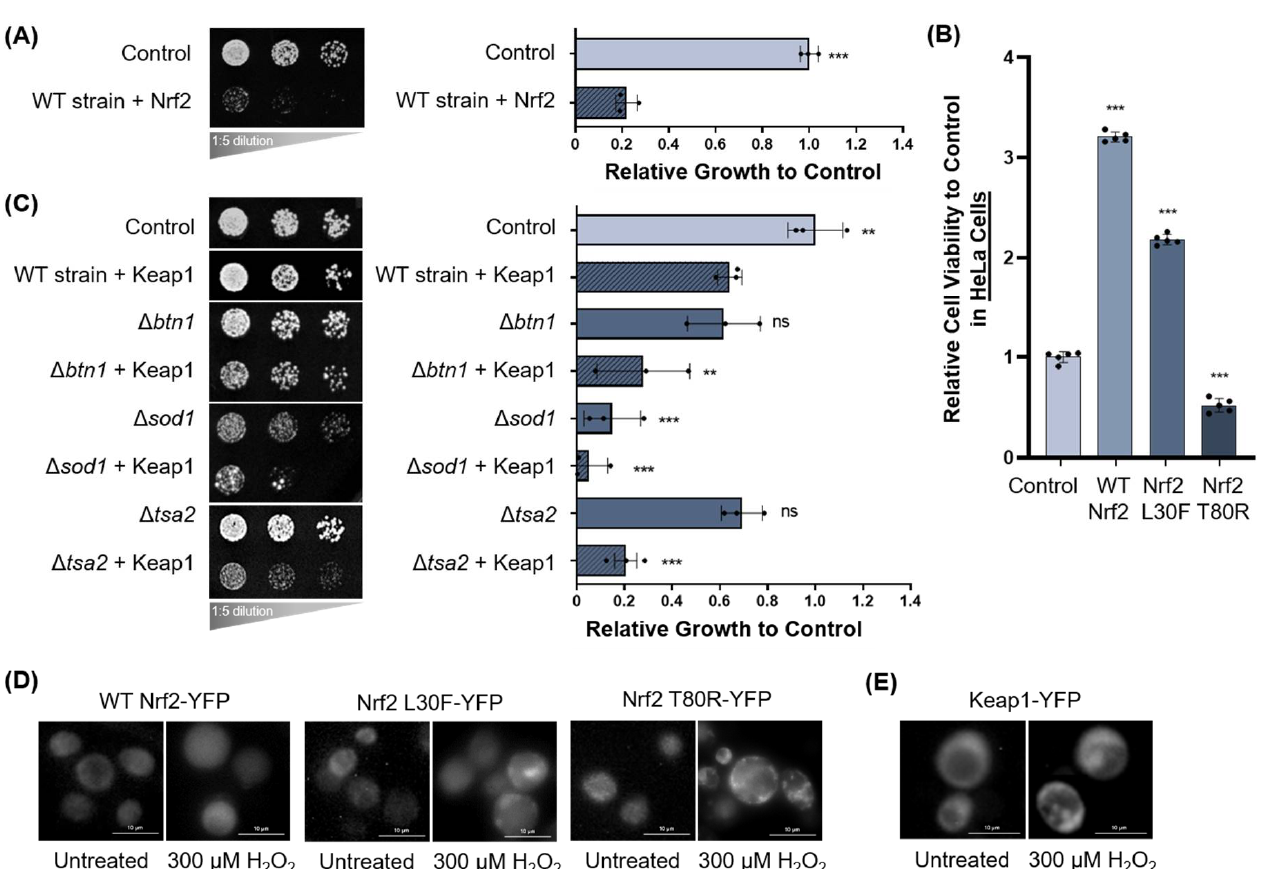
Figure 2. Nrf2 and Keap1 expression is modified by oxidative stress in yeast. ( A ) Growth assays for human Nrf2 transformed into wild-type yeast grown on agar plates. Growth is quantified to the right relative to the empty vector control. Only significant data is shown. ( B ) Relative cell viability of human HeLa cells transfected with wild-type Nrf2 and its mutant variants. ( C ) Human Keap1 transformed into yeast deletion strains for various oxidative stress genes grown on agar plates. Only significant data is shown. Growth is quantified to the right relative to the empty vector control. ( A – C ) Means derived from three biological replicates were used during analysis. Means were analyzed using one-way ANOVA followed by Tukey’s post hoc test. Data are expressed as mean ± SD. p < 0.05 was considered statistically significant; ** p < 0.01, *** p < 0.001; p = ns (non-significant). ( D )